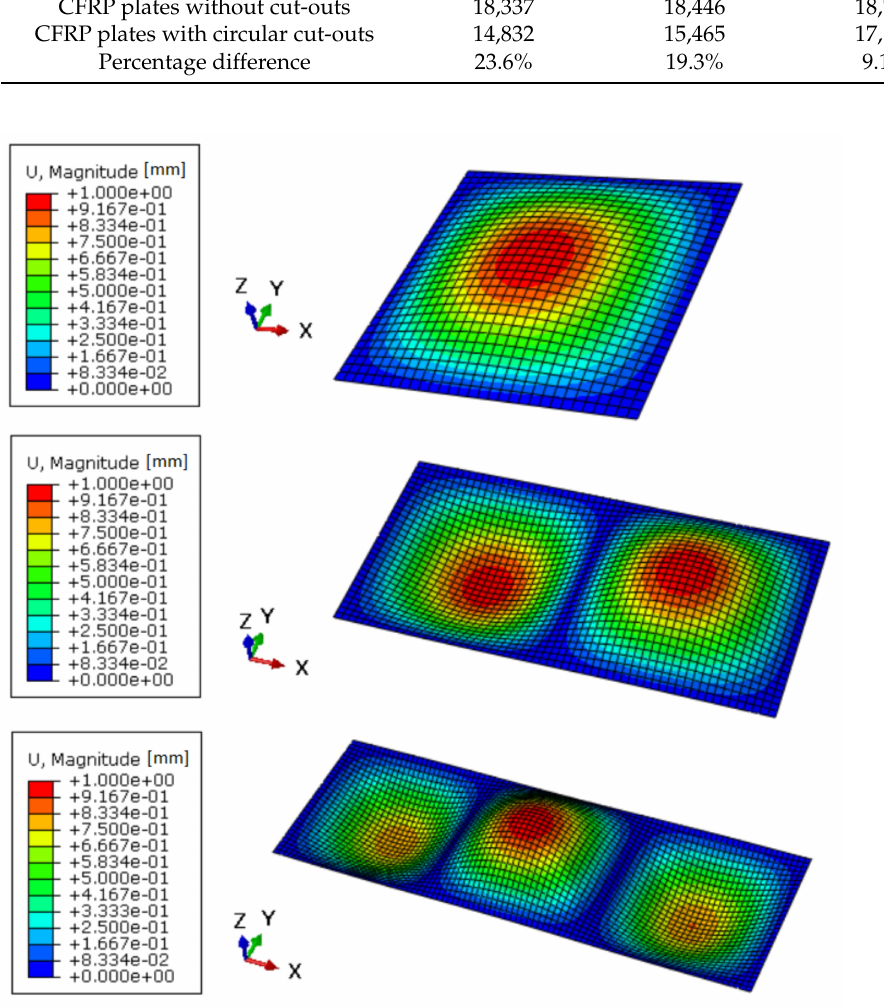
Figure 4. First buckling modes of plates without cut-outs with normalized displacement magnitudes in